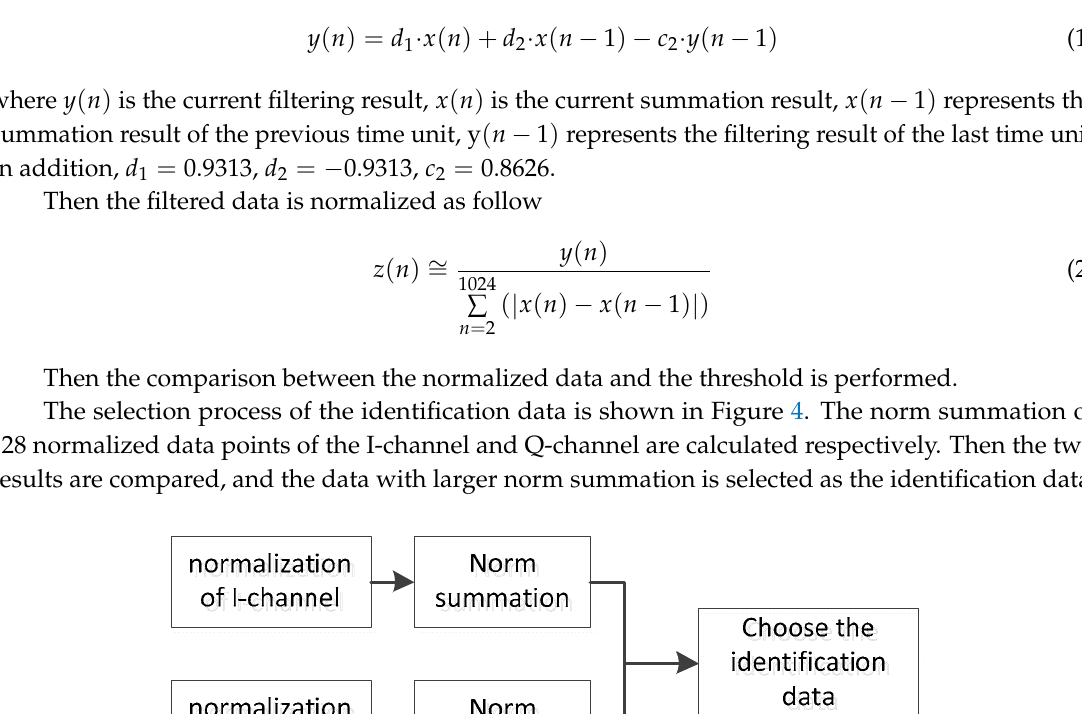
Figure 5. Feature extraction and identification.